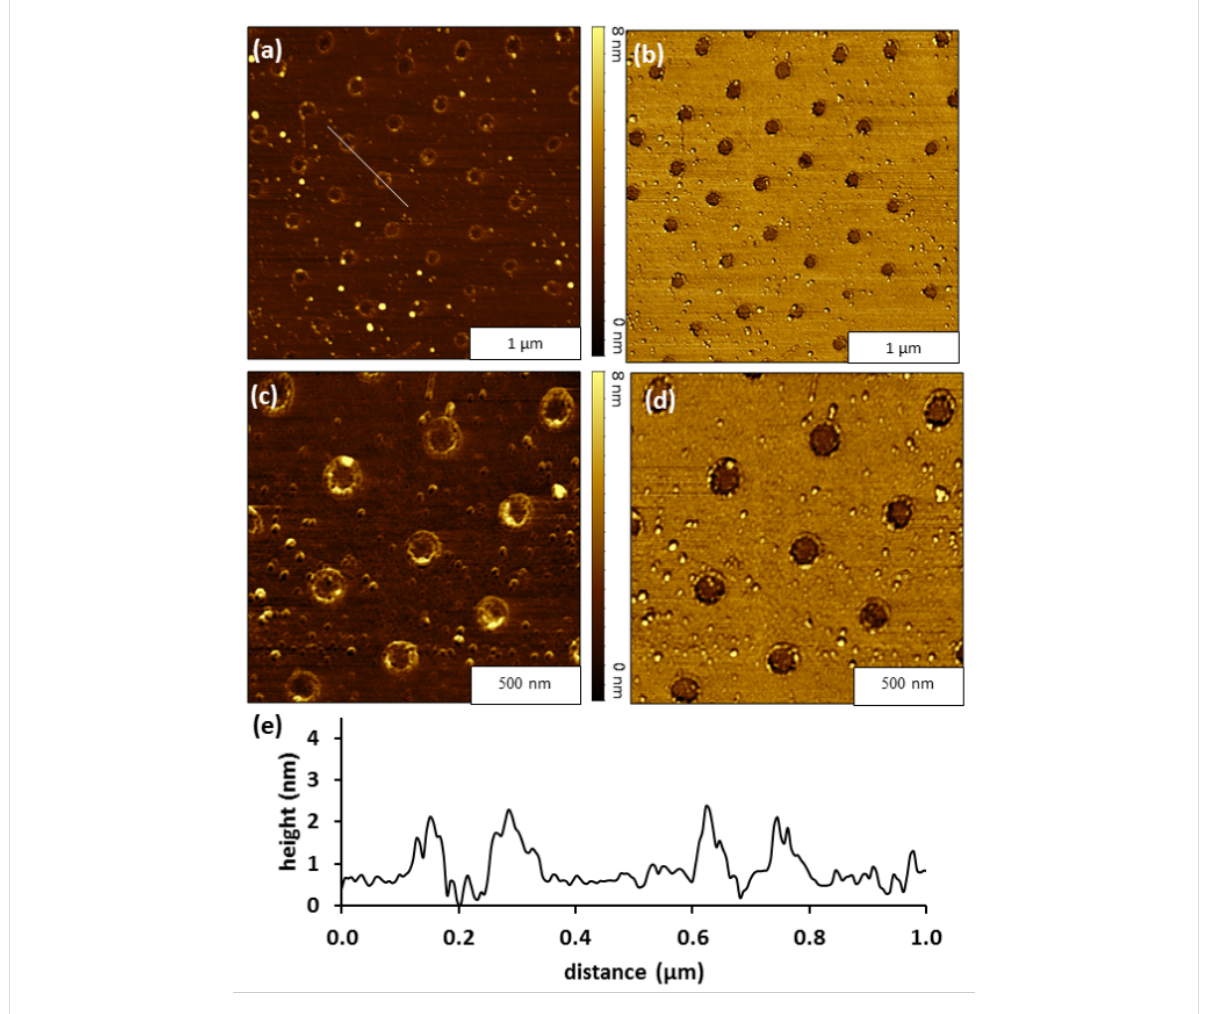
Figure 2: Nanoholes within a thin film of OTS. (a) Topography frame, 3 × 3 µm 2 ; and simultaneously acquired (b) phase image. (c) Zoom-in topo- graph of nanoholes and corresponding (d) phase image. (e) Cursor profile for the line in (a).